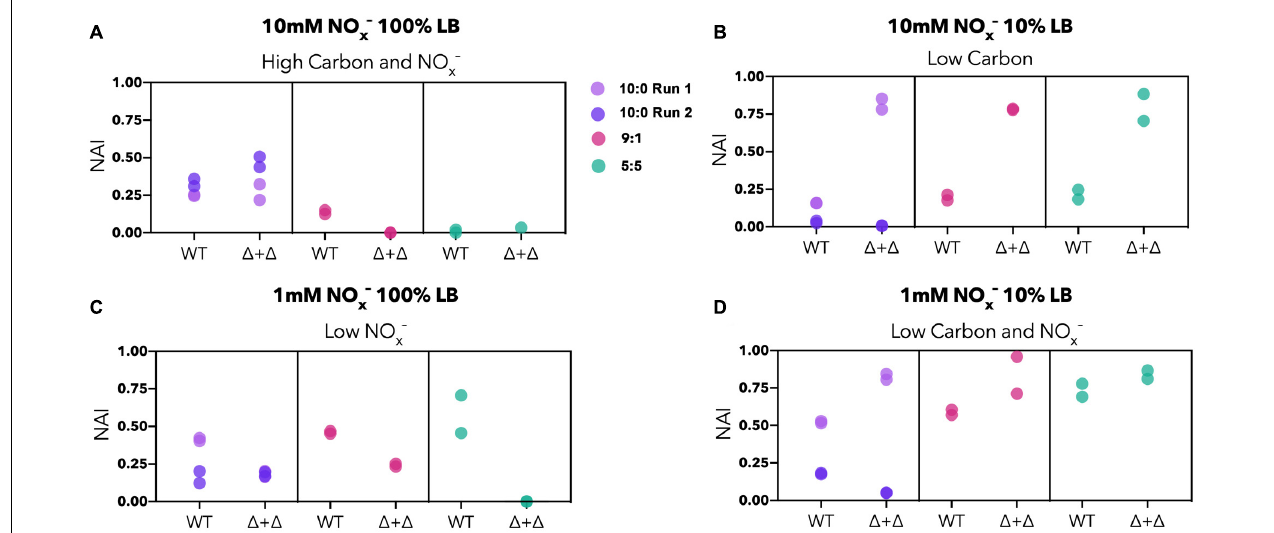
FIGURE 5 | NO 2 − accumulation index (NAI) for generalist and specialist cultures in LB. Stoichiometric ratios are plotted separately for (cid:49) + (cid:49) co-cultures and WT for each nutrient regime (10:0 run 1, lavender; 10:0 run 2, dark purple; 9:1, red; 5:5, green). For both WT and (cid:49) + (cid:49) , n = 4 for the 10:0 NO 3 − /NO 2 − ratio and n = 2 for the 9:1 and 5:5 ratio for each nutrient regime, and n = 8 for each nutrient regime including all depicted ratios, omitting 1:9. NAI relates to synchronicity, with synchronous cultures exhibiting low NAI and asynchronous cultures exhibiting high NAI. (A) The NAI is low to moderate for high carbon and NO x − regimes; (B) NAI is generally higher for (cid:49) + (cid:49) for low carbon regimes, but variable between replicates; (C) NAI is generally higher for WT for low NO x − regimes; (D) NAI can reach high values for low carbon and NO x − but is variable between